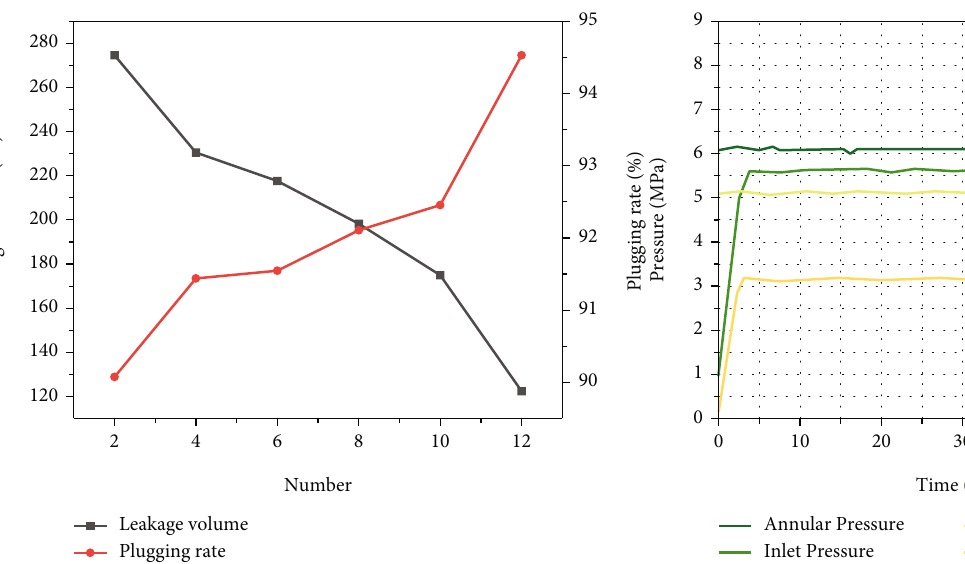
Figure 13: Change of plugging agent performance. Figure 14: Experiment 3 plugging pressure change.